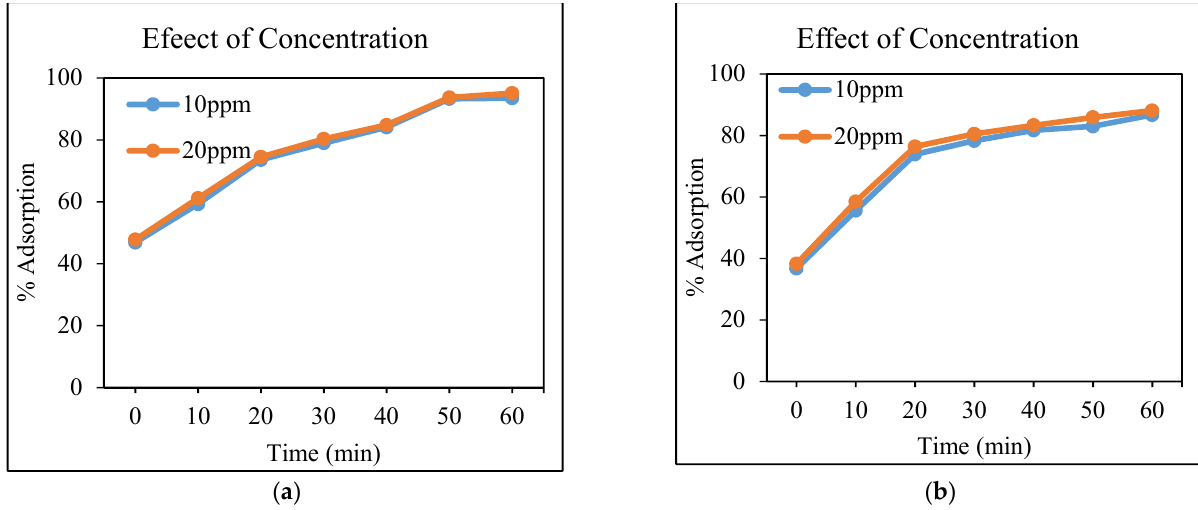
Figure 7. Removal (in percentage) of Cd ( a ) and Cr ( b ) using the CeO 2 /corncob nanocomposite as a function of initial concentration (at optimum dose).